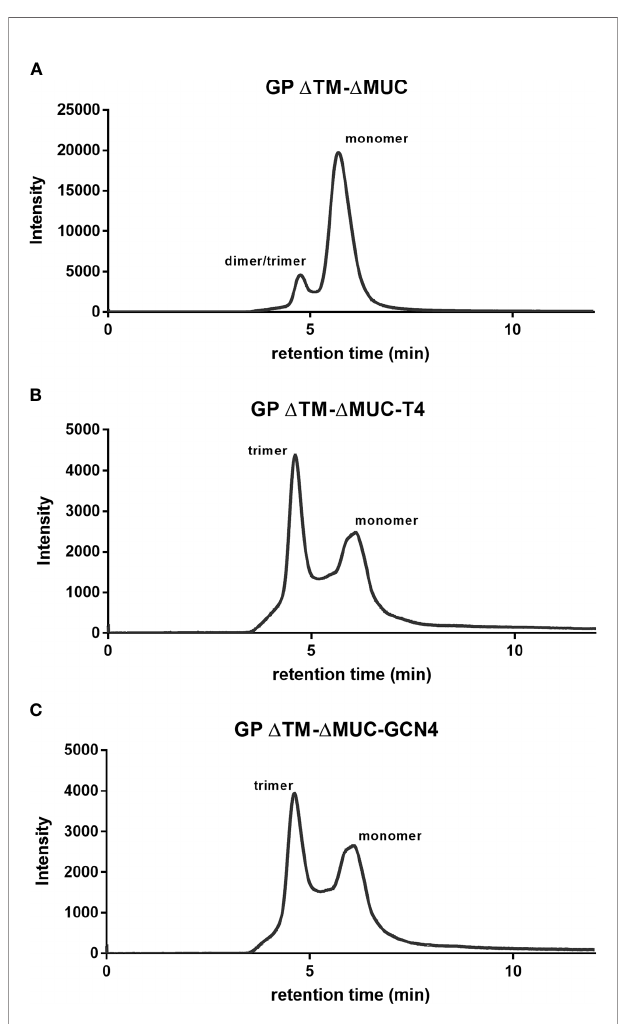
FIGURE 2 | The insertion of a C-terminal trimerization motif drives the trimerization of the GP D TM- D MUC protein. SEC pro fi les of (A) GP D TM-